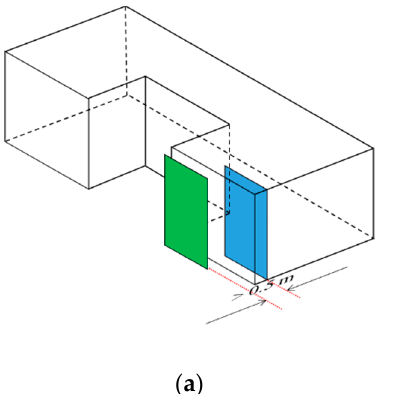
Figure 3. Adjacent rooms, assigned numbers 1 and 2, in order of detection in the processing. 2.1.5. Wall Intersection